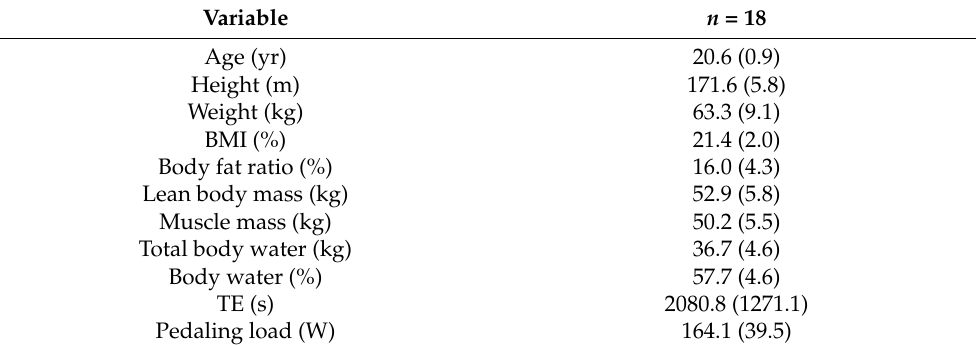
Table 1. Characteristics and exercise data of study